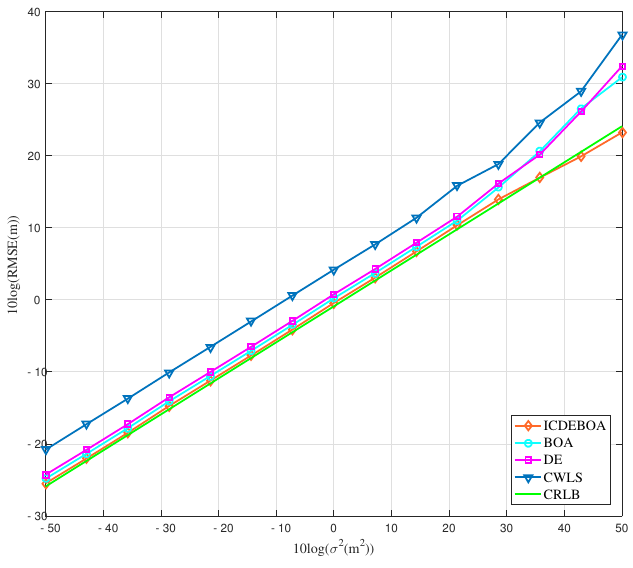
Figure 4. RMSE performance of different algorithms vs. p for first simulation case.